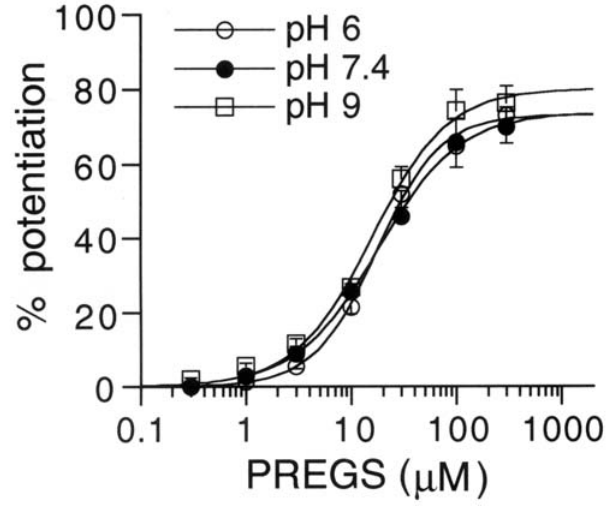
Figure 4. Effects of PREG and DHEAS on PREGS-induced Kir2.3 currents. (A) Representative current responses to 30 m M PREGS and to 30 m M PREGS in the presence of 100 m M PREG in a Xenopus oocyte expressing Kir2.3 channels. Current responses were measured at a membrane potential of 2 70 mV in an hK solution containing 96 mM K + . (B) Comparison of PREGS-induced Kir2.3 currents in the presence or absence of PREG or DHEAS. Concentrations of PREGS, PREG, and DHEAS were 30, 100, and 100 m M, respectively. Current responses to PREGS in the presence of PREG or DHEAS were normalized to the amplitude of PREGS-induced currents in the absence of PREG or DHEAS (control). Data are expressed as mean 6 SEM.